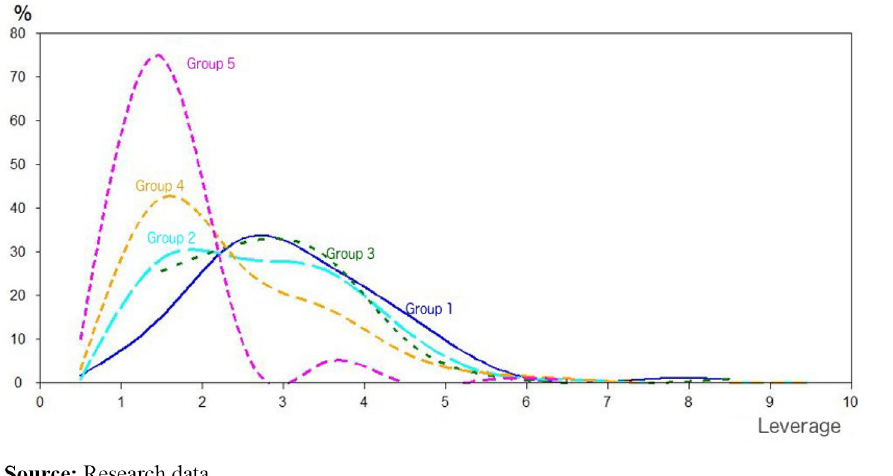
Figure 2. Frequency distribution for leverage ratios according to the cooperative governance